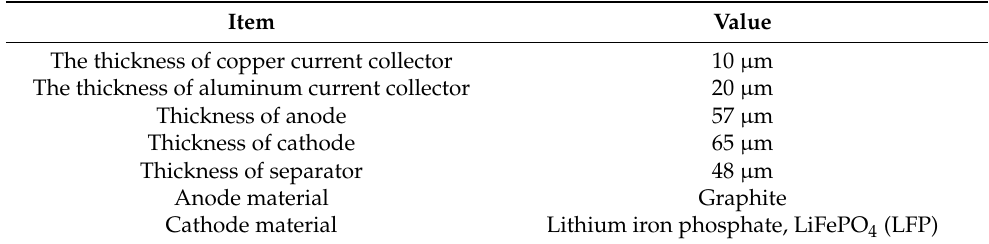
Table 2. The specification of the aftermarket LIB used in this